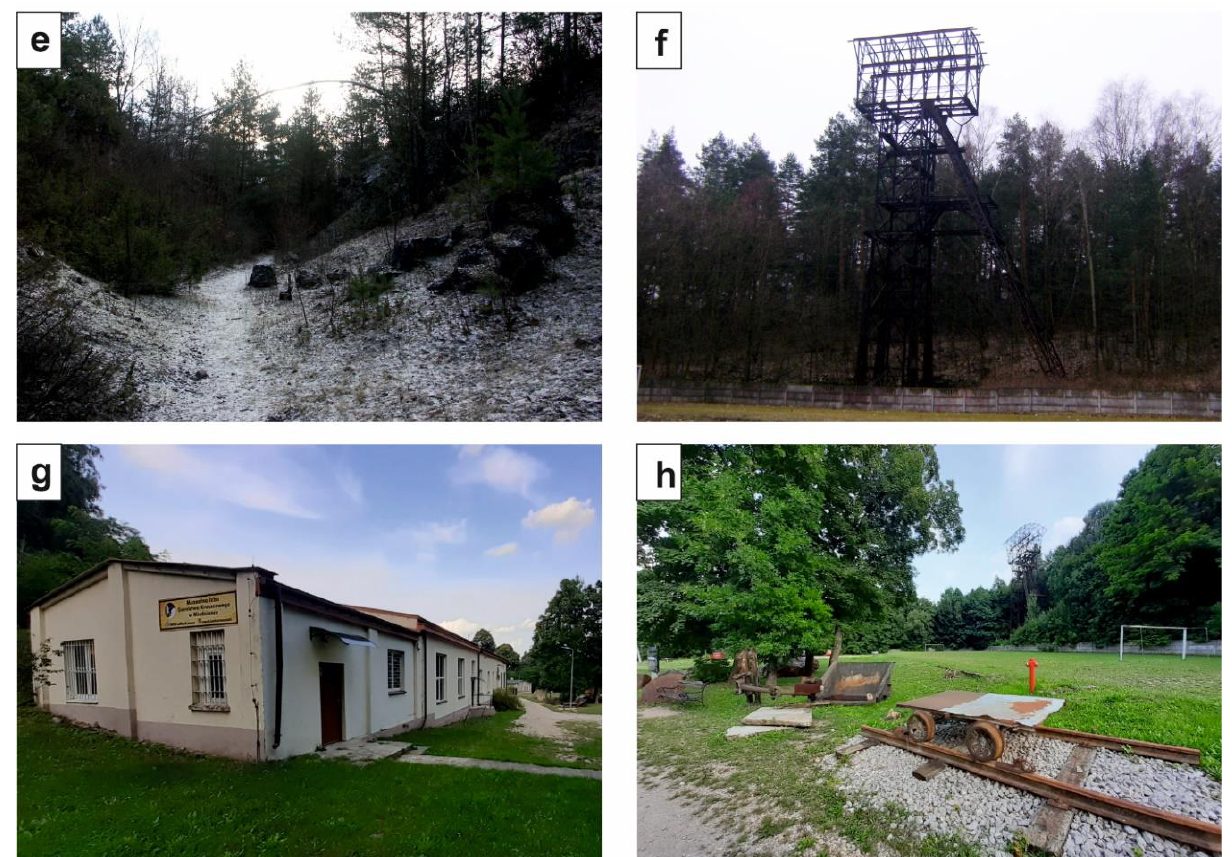
Figure 3. Field photos showing historical mining activity in the Miedzianka Mountain: ( a ) the summit of the mountain with shallow morphological depressions, which are the remains of collapsed mining excavations (funnels), with a view towards the northwest; ( b ) peak of the Miedzianka Mountain, with visible excavation remains; ( c ) heap left over after copper mine extraction from the Zofia adit; ( d ) abandoned quarry on the eastern slope of the Miedzianka Mountain, showing the Devonian limestones; ( e ) entrance to the quarry; ( f ) the steel structure of the shaft hoist tower of historical shaft on the Miedzianka Mountain; and ( g , h ) a building and exposition of rocks, mining instruments and machines in the Museum Chamber of Ore Mining in Miedzianka.